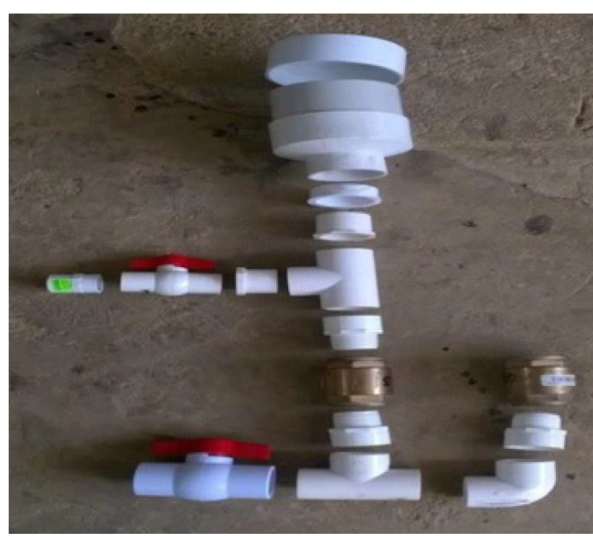
Figure 2. Photograph of the pump components.